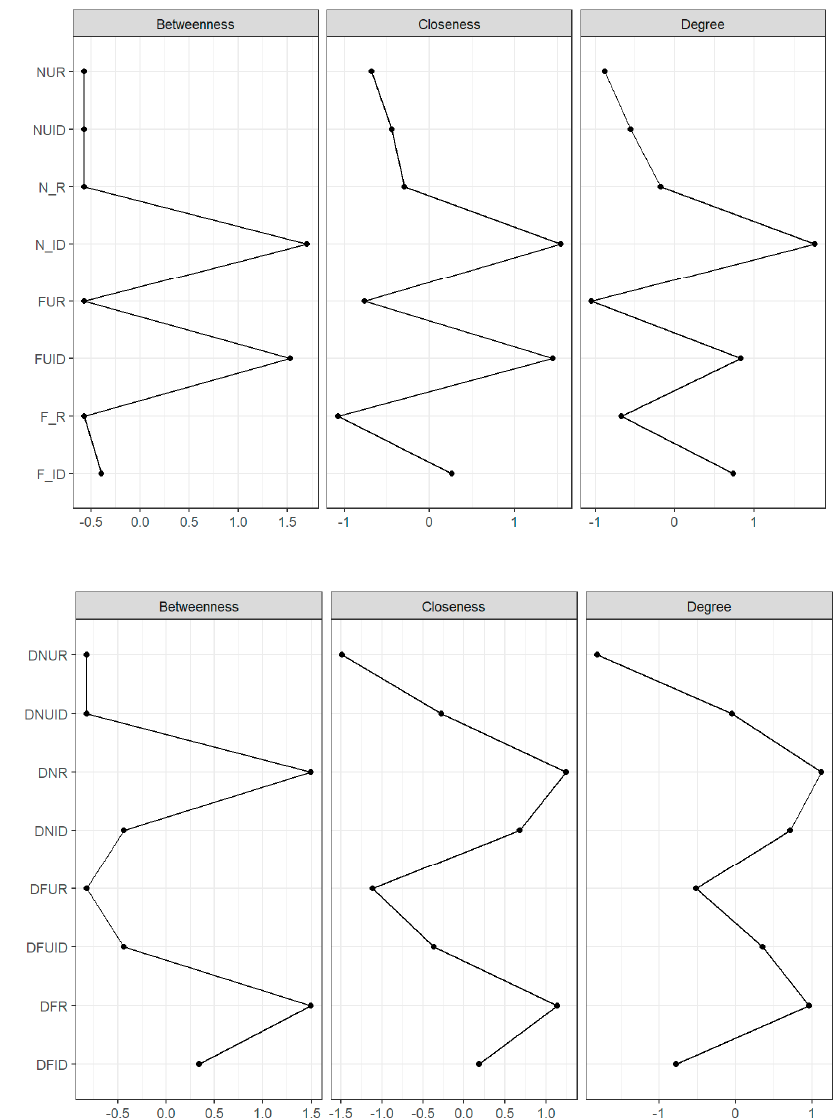
Figure 3. Betweenness (the number of shortest paths that pass through the node of interest), Closeness (the inverse of the sum of all shortest paths from the node of interest to all other nodes), and the Degree (the sum of the absolute input weights of that node). Target stimuli (on the top): NUR = Unrelated Masked Priming Word–Face; NUID = Unrelated Masked Priming Word–Word; N_R = Related Masked Priming Word–Face; N_ID = Identity Masked Priming Word–Word; FUR = Unrelated Masked Priming Word–Face; FUID = Unrelated Masked Priming Face–Face; F_R = Related Masked Priming Word–Face; F_ID = Identity Masked Priming Face–Face. Distracting stimuli (on the bottom): DNUR =